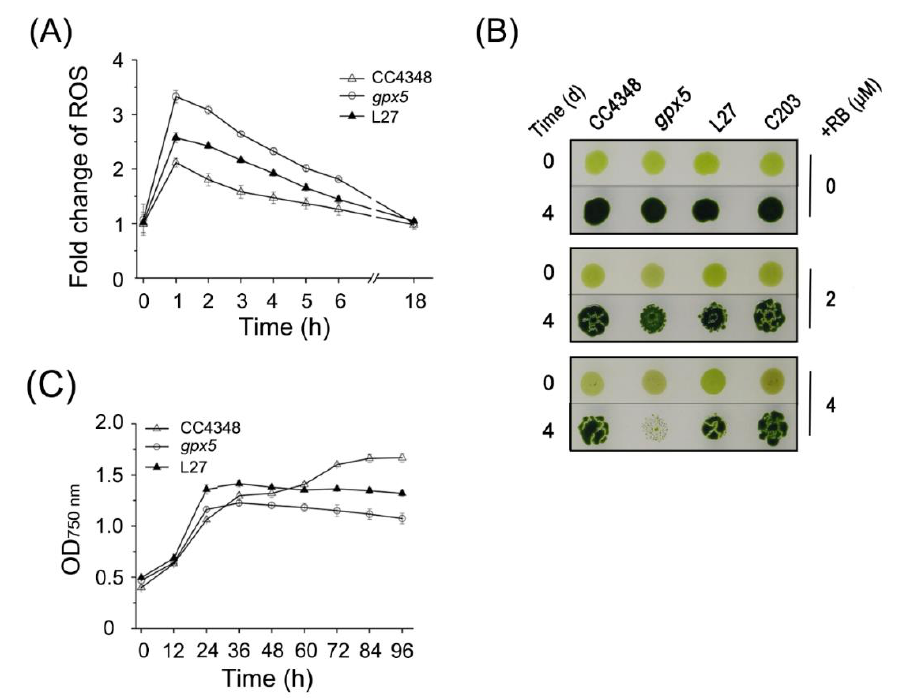
Figure 1. GPX5 maintains ROS homeostasis in Chlamydomonas reinhardtii . ( A ) Intracellular ROS concentrations in the cells of CC4348, the gpx5 mutant, and the rescued strain L27 treated with 2 μM rose bengal (RB) for 1 h. ( B ) The effect on the growth of CC4348, the gpx5 mutant, and the complemented lines L27 and C203 treated with 2 or 4 μM RB for 1 h. ( C ) Growth curves of CC4348, the gpx5 mutant, and L27 cells under laboratory growth conditions. The error bars represent standard deviations of three biological replicates.